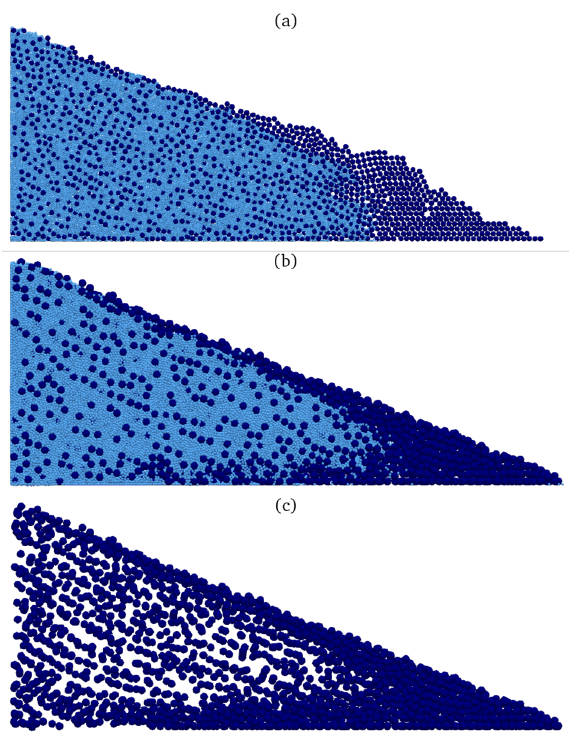
Figure 4. Heaps patterns as results of 3D simulations; (a) mass ratio m LS = 1, size ratio is 3:1, f = 0 . 6 g/ s , h = 50mm and D = 3mm, (b) mass ratio m LS = 1, size ratio is 3:1, f = 0 . 4 g/ s , h = 10mm and D = 10mm; then (c) presents (b) deposit with the smaller particles hidden.